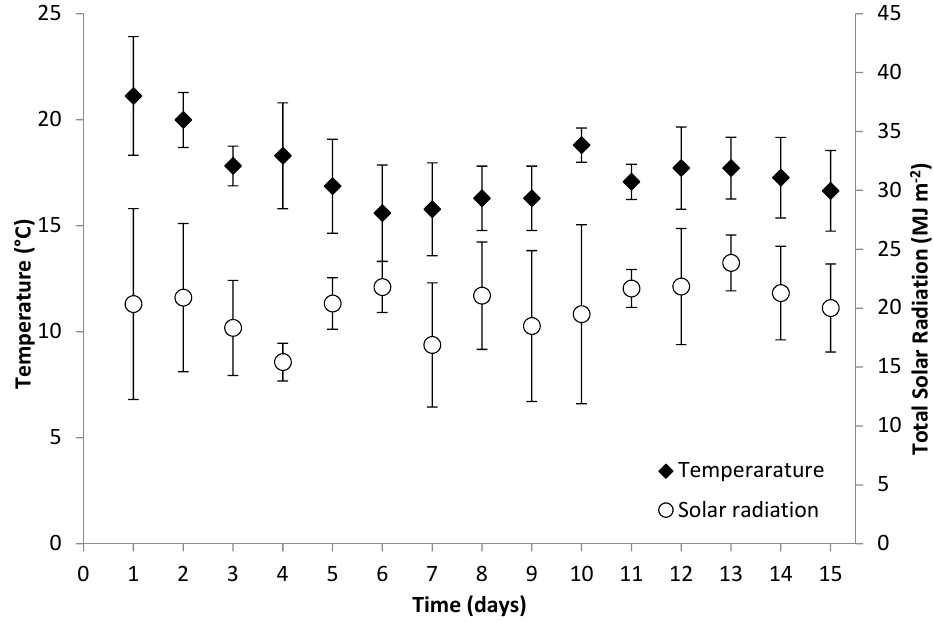
Figure 2. Average daily ambiance temperature and total solar radiation incident in the 2.6 m 3 PBRs, while culturing Nannochloropsis oceanica . The presented values are the average values obtained in three biologically independent replicates and the error bars represent the respective standard deviations.